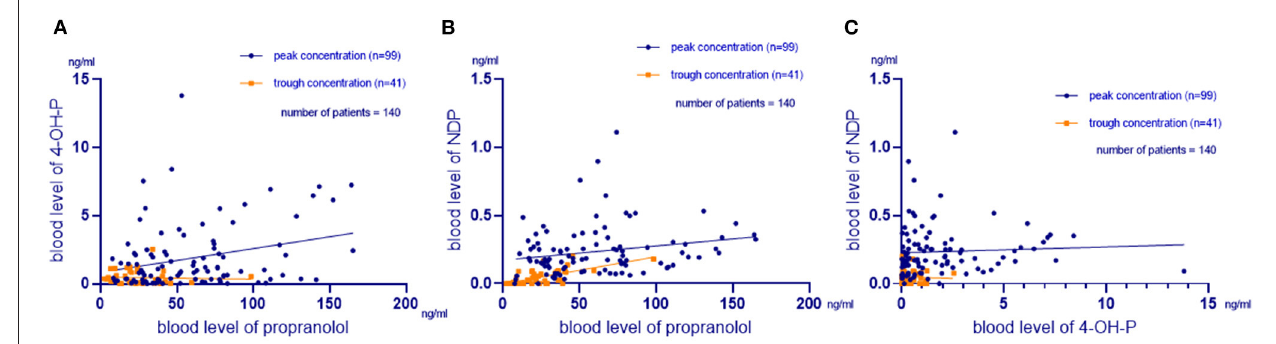
FIGURE 1 | Relationship between propranolol, 4-OH-P, and NDP. (A) Relationship between the blood propranolol and 4-hydroxypropranolol (4-OH-P) levels. The mean blood levels of propranolol and 4-OH-P were 49.99 ± 36.93 and 1.48 ± 2.12ng/ml, respectively. A correlation was found between the two parameters ( R 2 = 0.360, p = 0.000). (B) Relationship between the blood propranolol and N-deisopropylpropranolol (NDP) levels. The mean blood levels of propranolol and NDP were 49.99 ± 36.93 and 0.18 ± 0.18ng/ml, respectively. A correlation was found between the two parameters ( R 2 = 0.399, p = 0.000). (C) Relationship between the blood 4-OH-P and NDP levels. The mean blood levels of 4-OH-P and NDP were 1.48 ± 2.12 and 0.18 ± 0.18ng/ml, respectively. A correlation was found between the two parameters ( R 2 = 0.194, p =